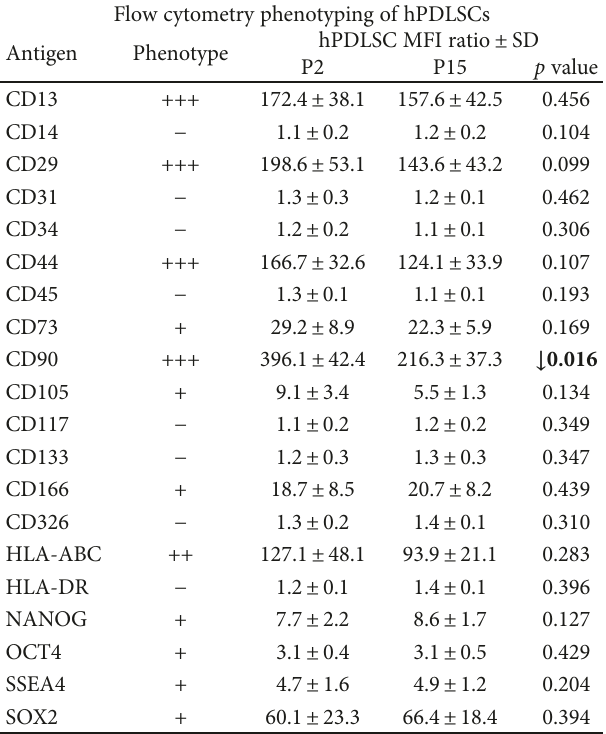
Table 1: Cyto fl uorimetric analysis of